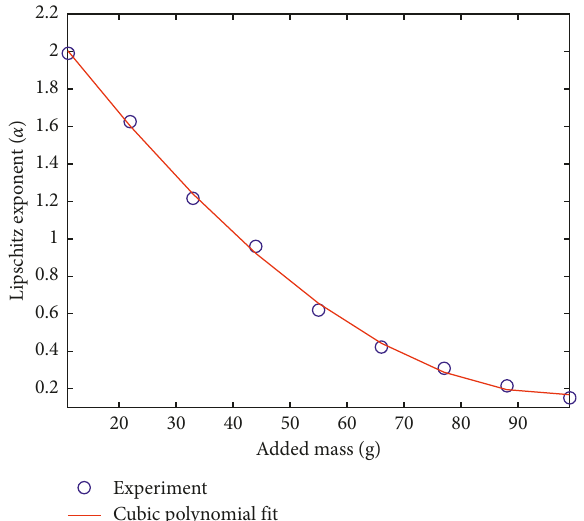
Figure 22: The change in the experimental Lipschitz exponent due to damage